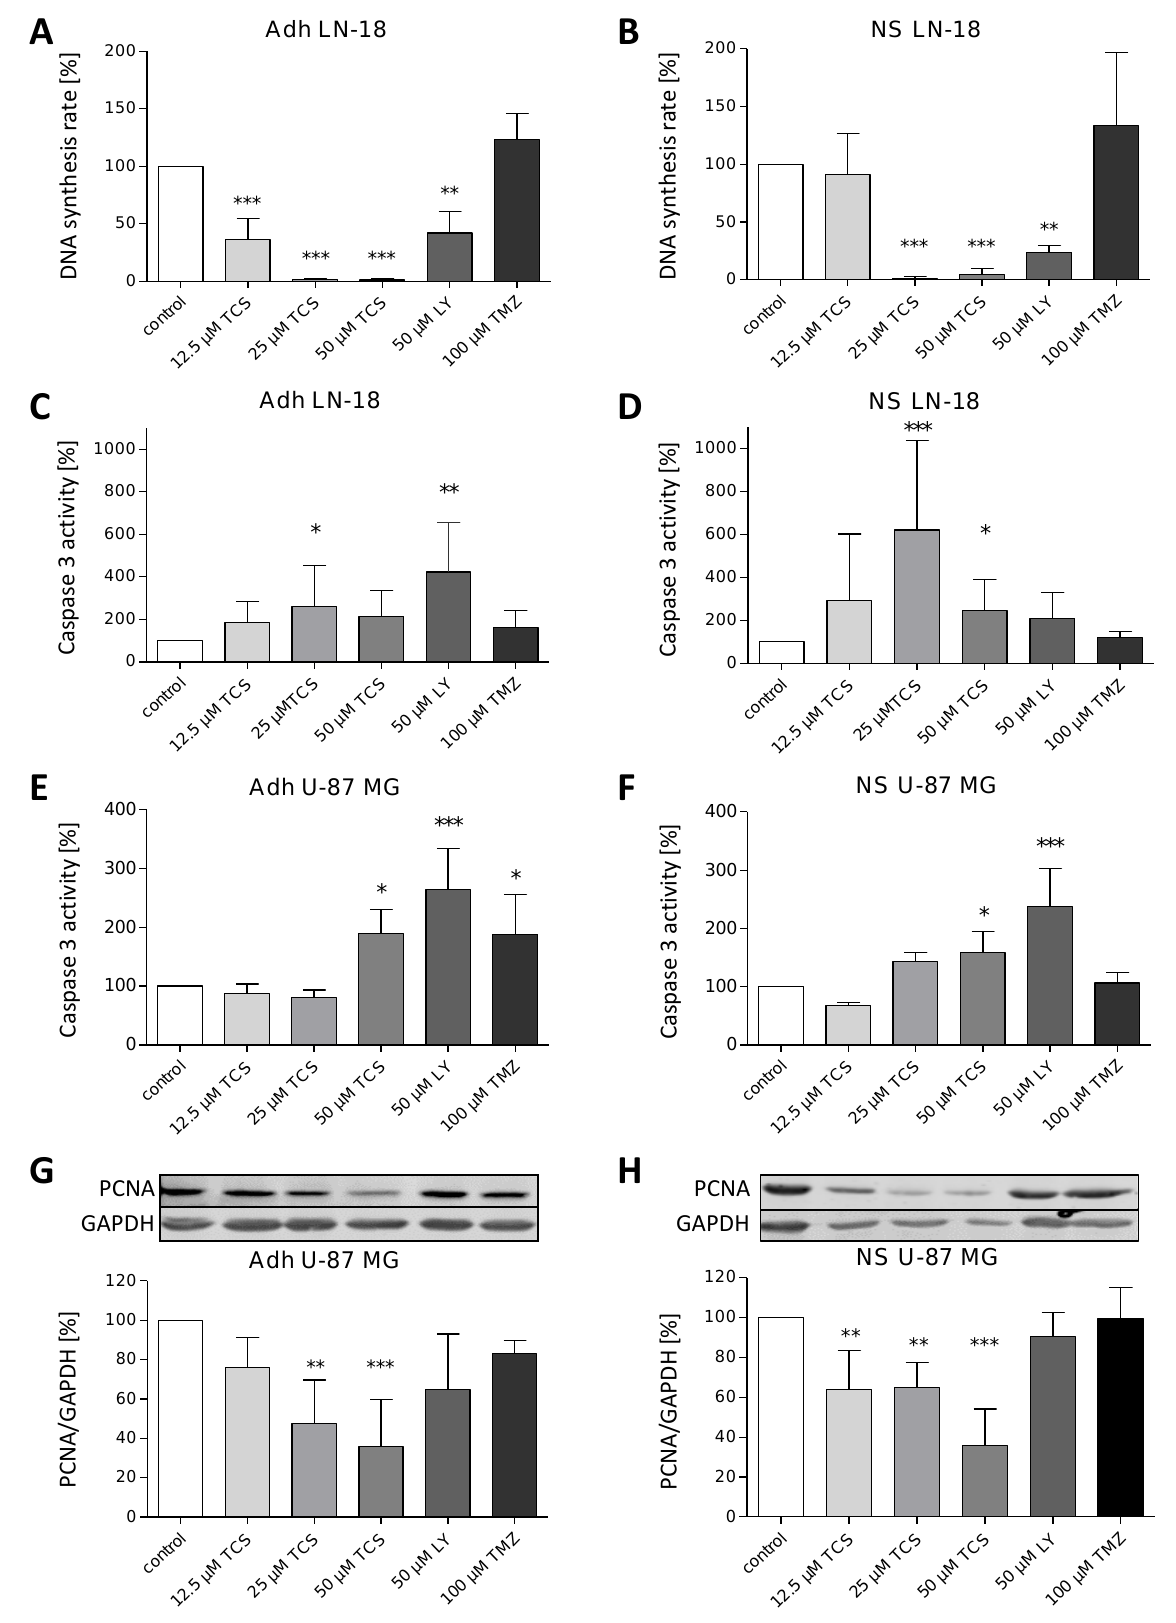
Figure 5. Pharmacological inhibition of PIM1 promotes a reduction in DNA synthesis rate and apoptosis. ( A , B ) BrdU cell proliferation assay was performed on LN-18 adherent cells ( A ) and neurospheres ( B ) to determine the DNA synthesis